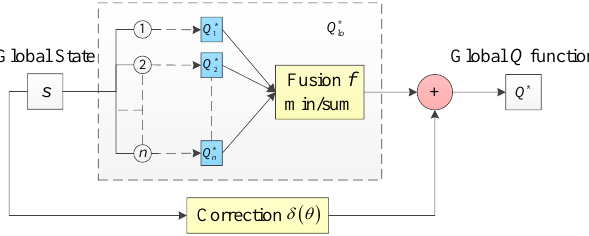
Figure 13. Utility decomposition with correction. Reprint from